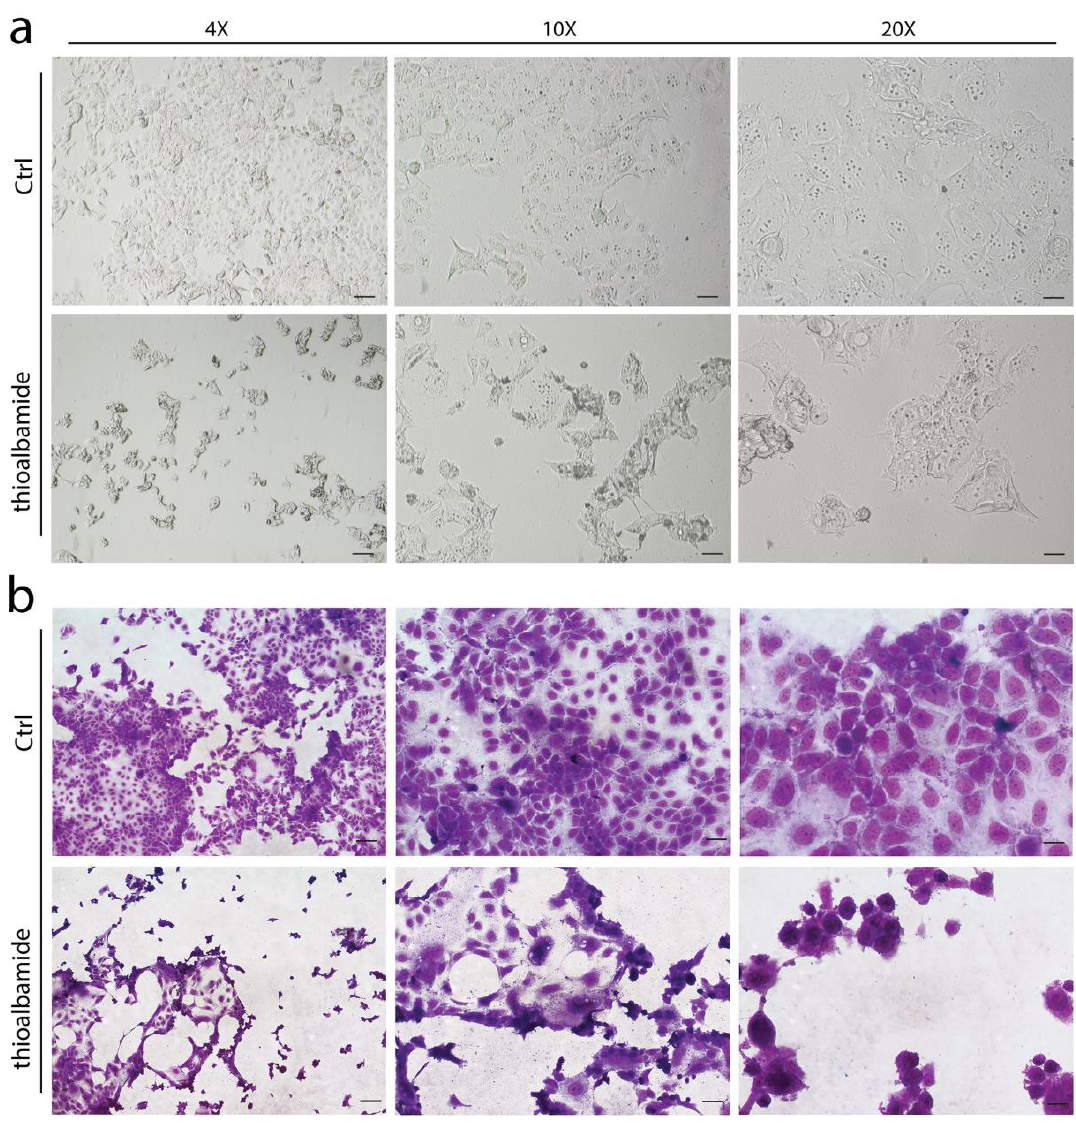
Figure 2. Thioalbamide affects cell morphology. MCF7 cells were treated with DMSO (Ctrl) or 50 nM thioalbamide, for 72 h, and cell morphology was evaluated by phase-contrast light microscopy ( a ) and May-Grunwald Giemsa staining ( b ). Scale bars: 4× (125 µm), 10× (50 µm), 20× (25 µm). Note that cell morphology after treatment was seriously affected.